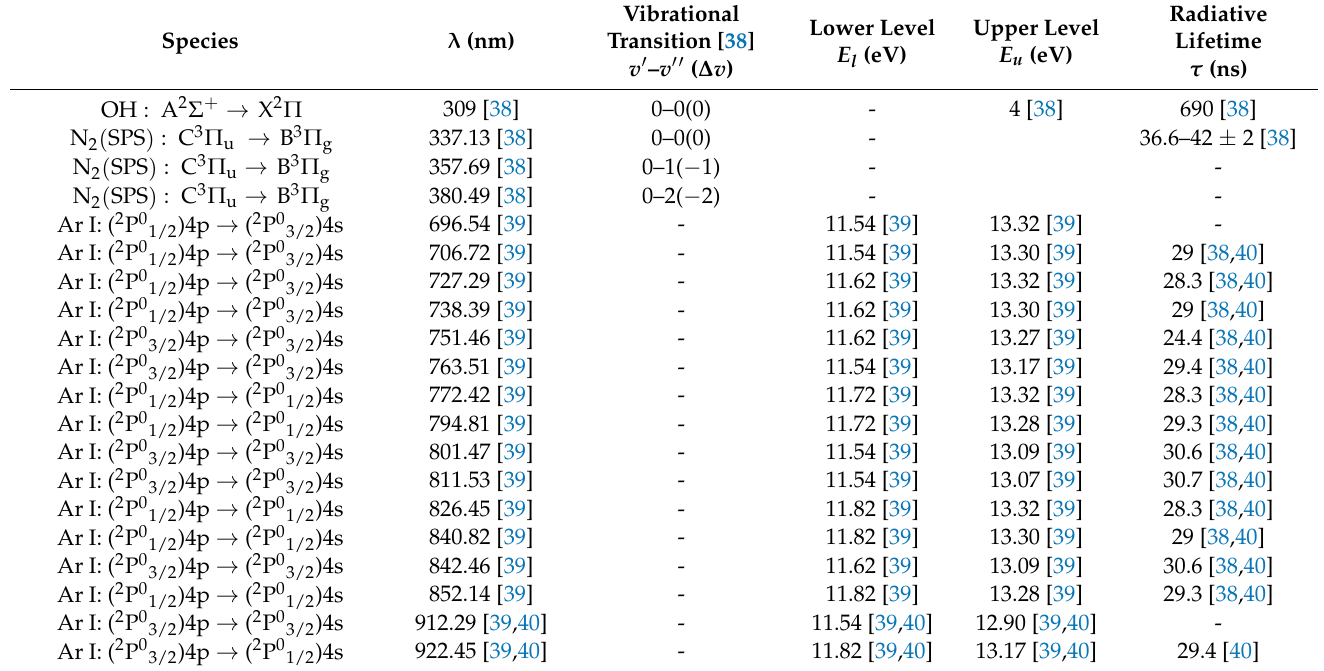
Figure 3. ( a ) and ( b ) Optical emission wide scan spectra in the UV-NIR range and species identification; all atomic lines in ( b ) refer to Ar (see Table 1 for details on species identification and transitions). ( c ) Experimentally and numerically determined rotational distributions of the ΟΗ : A (cid:2870) Σ (cid:2878) (0) − Χ (cid:2870) Π (0) molecule. Operating conditions: 11 kV pp , 17.5 kHz, and 1.5 slm. Table 1. Principal emissive species in the argon plasma jet.